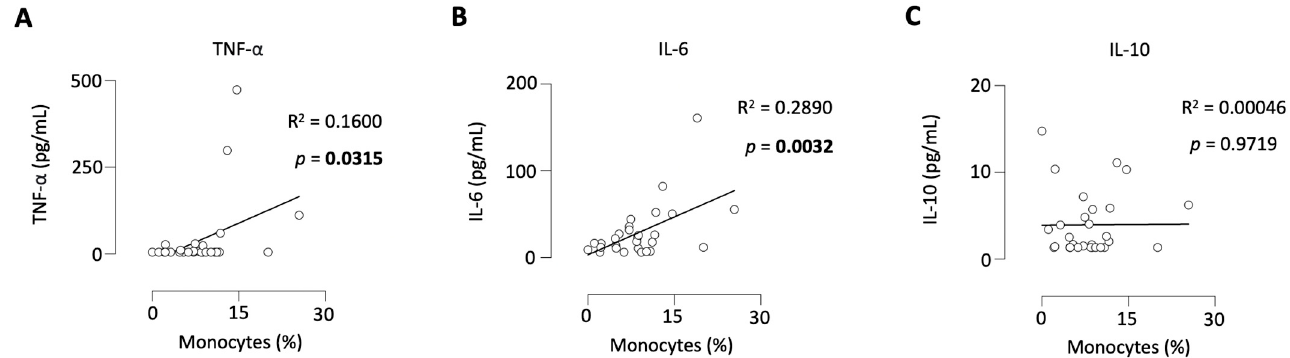
Figure 3 . Levels of monocytes correlated positively with the TNF- α and IL-6 plasma concentrations in PDAC patients. Levels of monocytes correlated to the concentration of TNF- α ( A ), IL-6 ( B ), and IL-10 ( C ) in the plasma of PDAC patients.